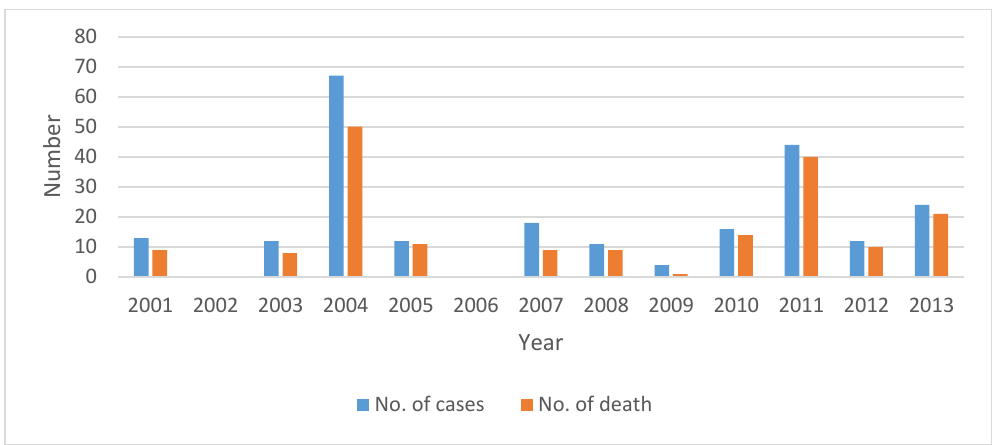
Figure 1. Number of cases and deaths due to human Nipah virus (NiV) infections in Bangladesh, 2001–2013.